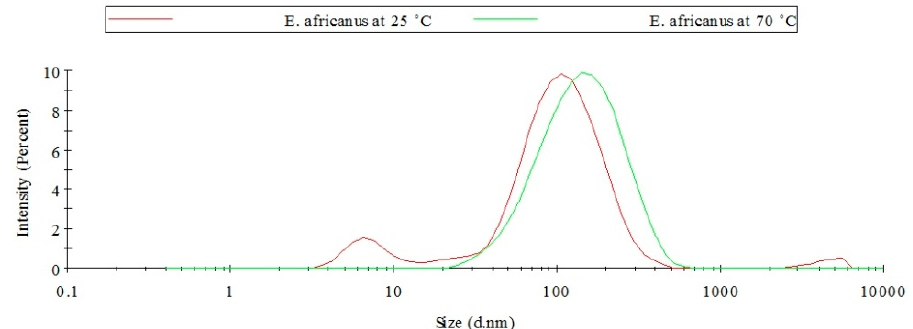
Figure 7. Particle size distribution for AuNPs produced from E . africanus.